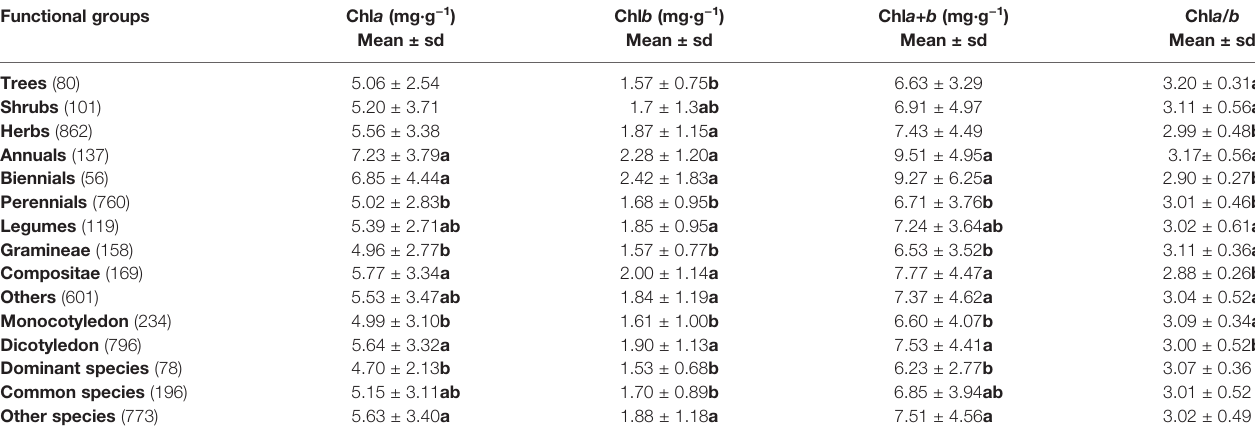
Mean ± standard deviations are shown and numbers of samples (n) in parentheses. Bold lowercase letters denote signi fi cant differences among groups (p < 0.05).